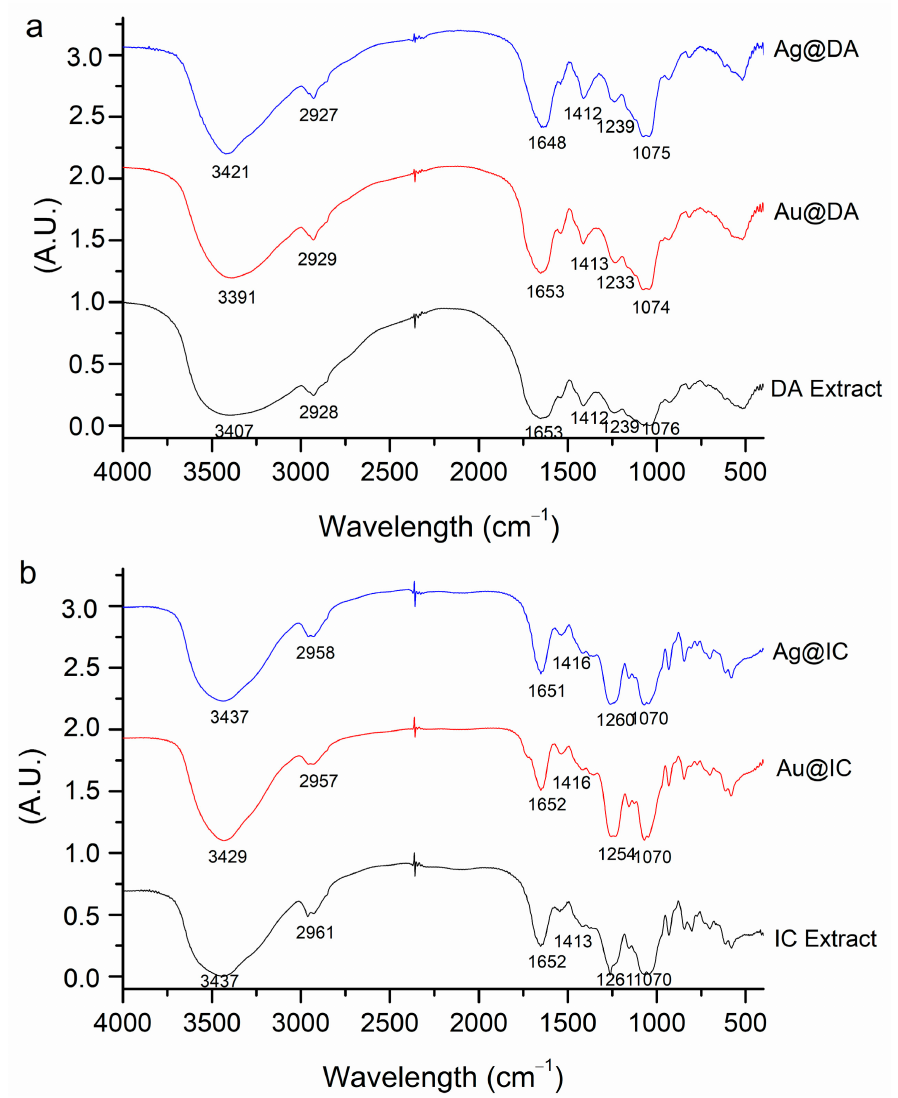
Figure 4. Fourier transform infrared spectra of ( a ) DA extract and ( b ) IC extract before and after nanoparticles were